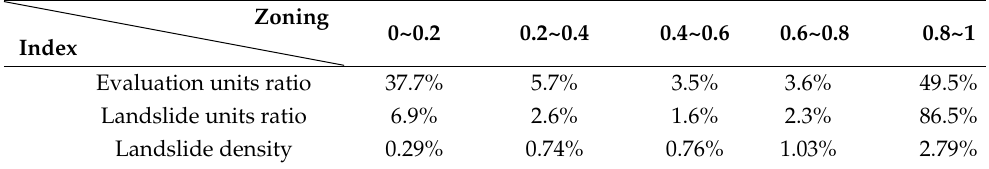
Table 6. Landslide susceptibility zoning based on the CNN